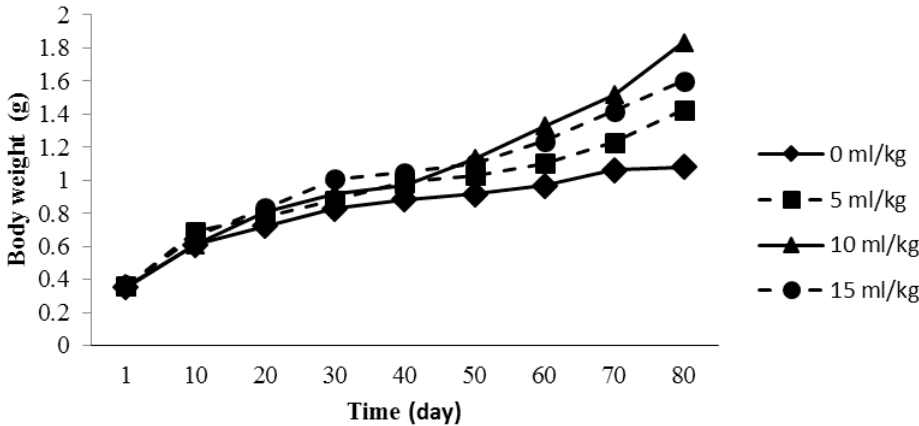
Figure 1. The growth trend of T. tambra fry at different dosage of probiotic during the